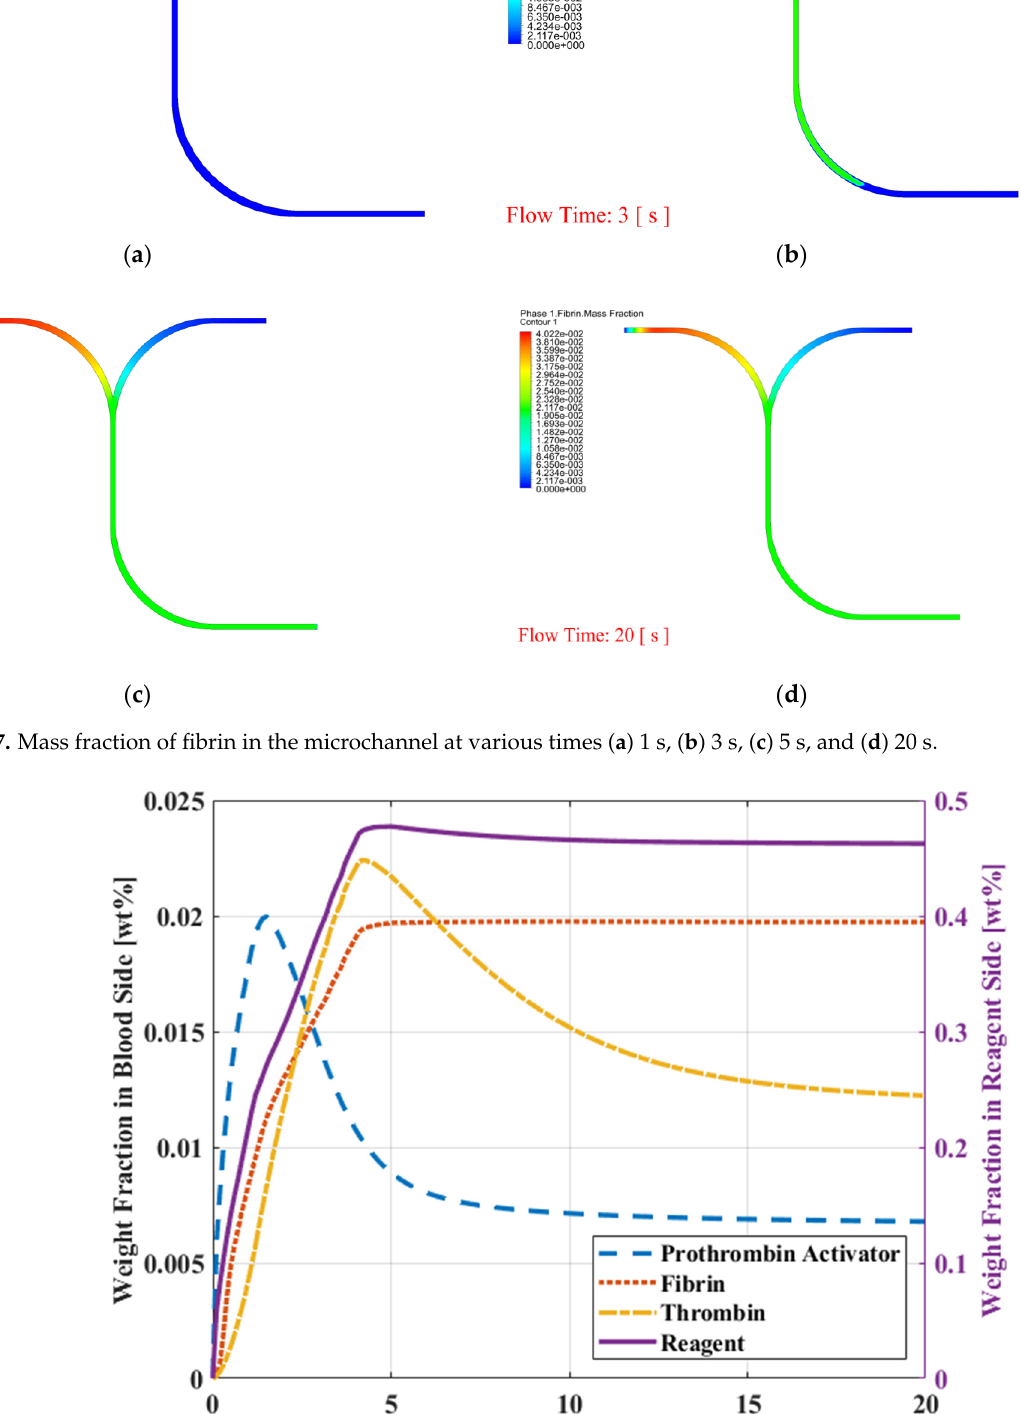
Figure 8. Average species weight fraction in the blood and reagent sides.